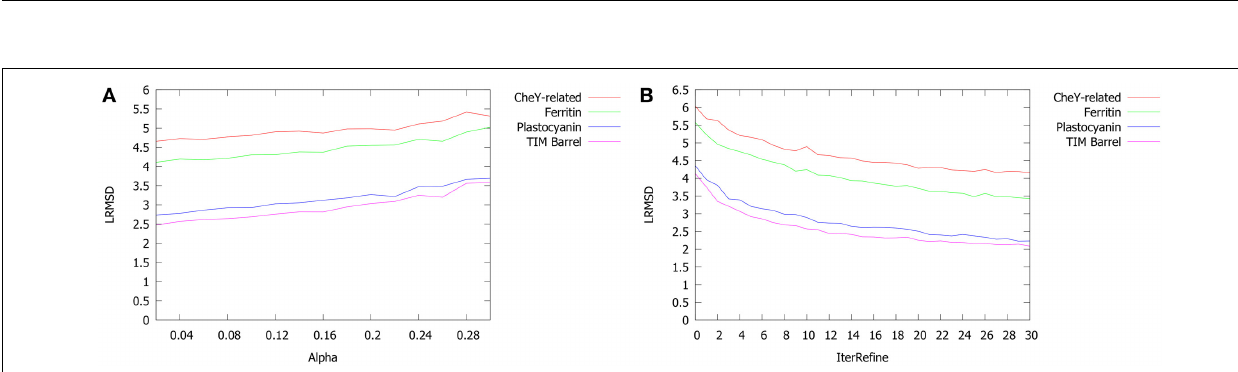
of proteins with the lowest RMSD alignments, we run BLAST and considered the percentage of residues with positive matches in the 6380 couples, 3835 ( (cid:6) 60%) have PPos < 5% and 6173 ( (cid:6) 97%) have PPos < 15%.